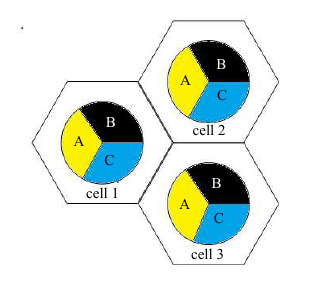
Figure 2. Interior sector